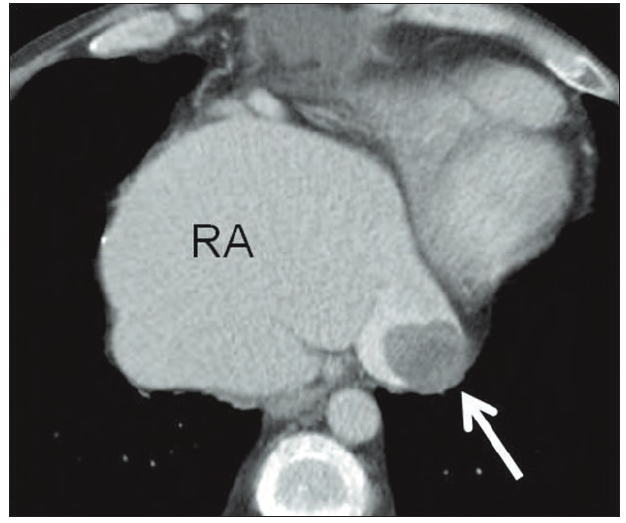
Fig. 4. Venous phase transaxial image from a CT scan in a 54-year-old man demonstrates a filling defect in the coronary sinus in keeping with a thrombus.